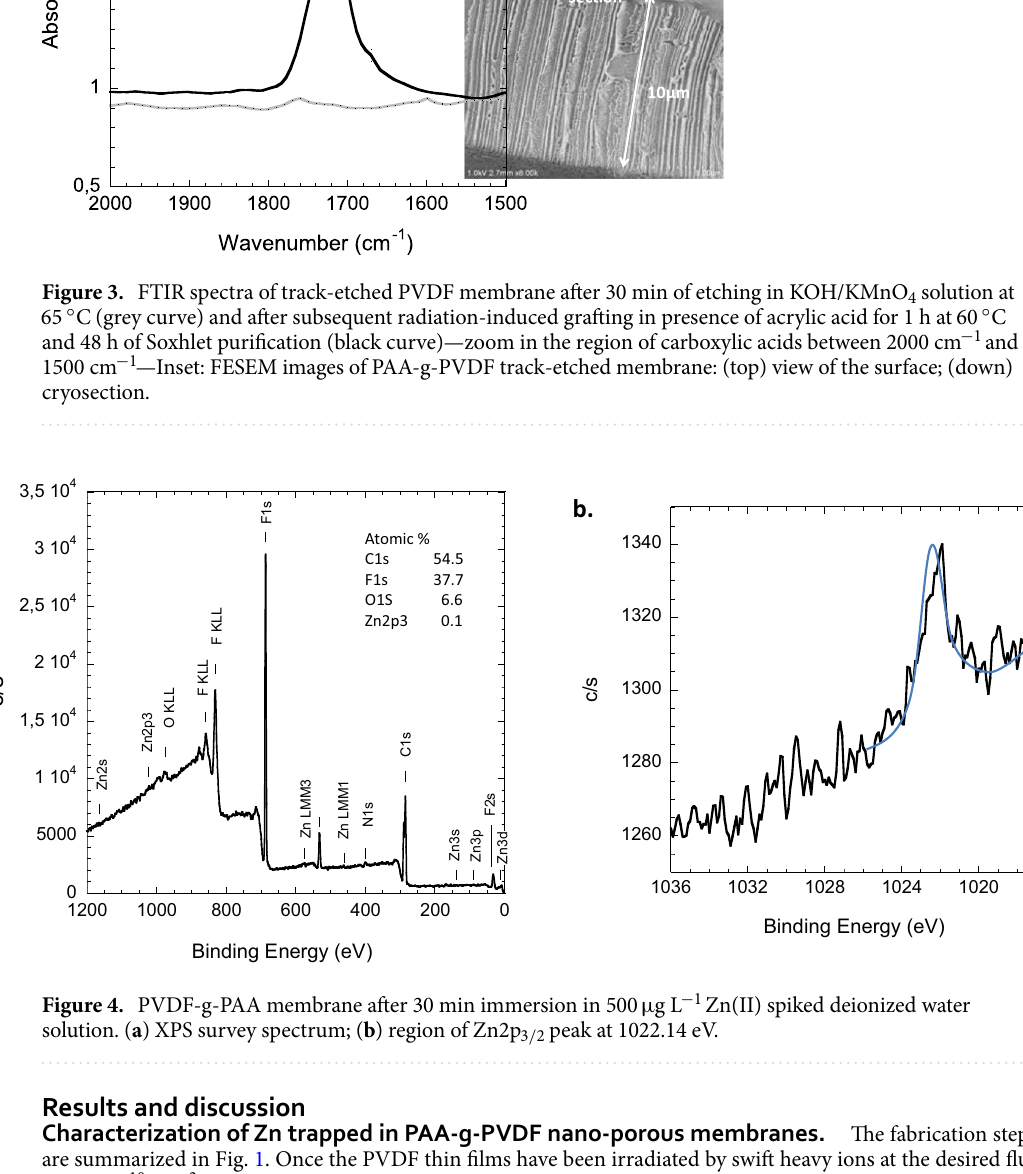
Figure 4. PVDF-g-PAA membrane after 30 min immersion in 500 µ g L − solution. ( a ) XPS survey spectrum; ( b ) region of Zn2p 3 / 2 peak at 1022.14